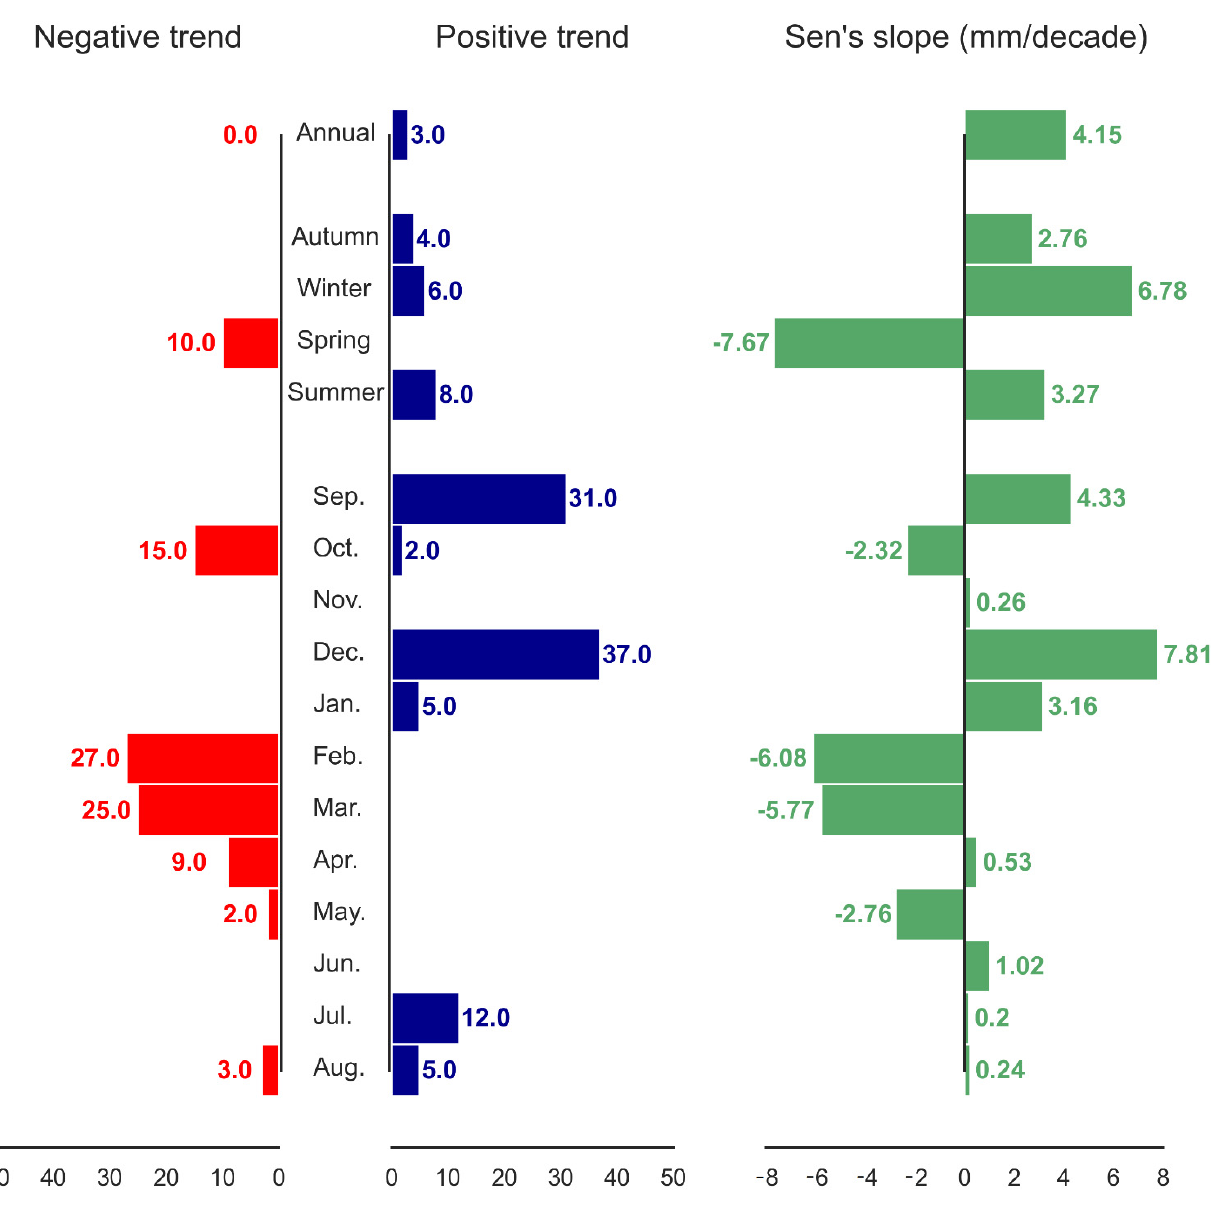
Figure 6. Percentage of the station with significant trends ( left ) and Sen’s slope of rainfall ( right ) in the Medjerda catchment at different temporal scales (90% confidence level).